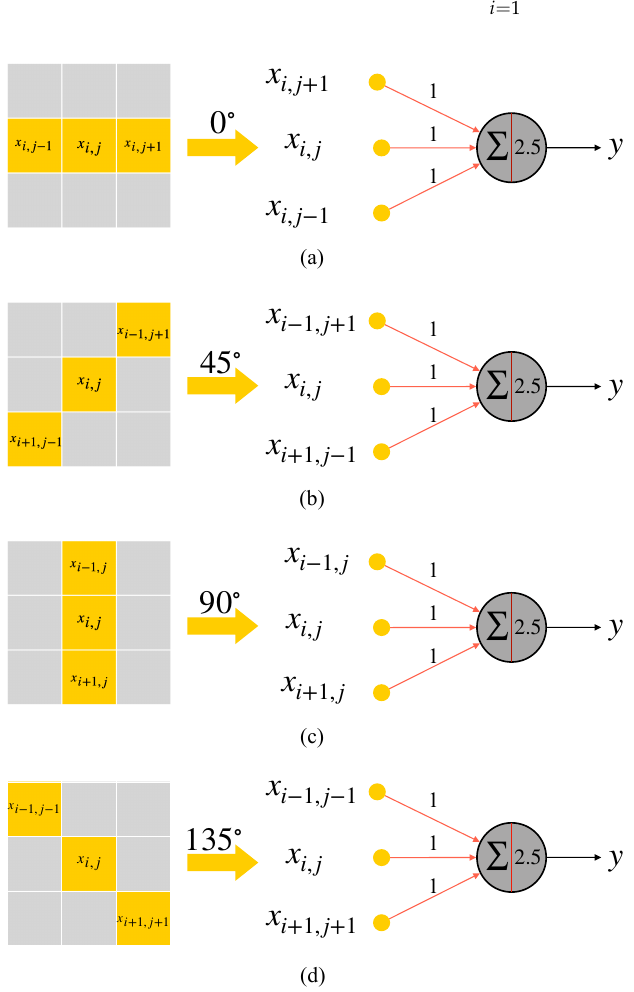
Figure 8. Four types of orientation-selective simple cells and their optimal stimuli orientation. ( a ) 0 ◦ - selective simple cell. ( b ) 45 ◦ -selective simple cell. ( c ) 90 ◦ -selective simple cell. ( d ) 135 ◦ -selective simple